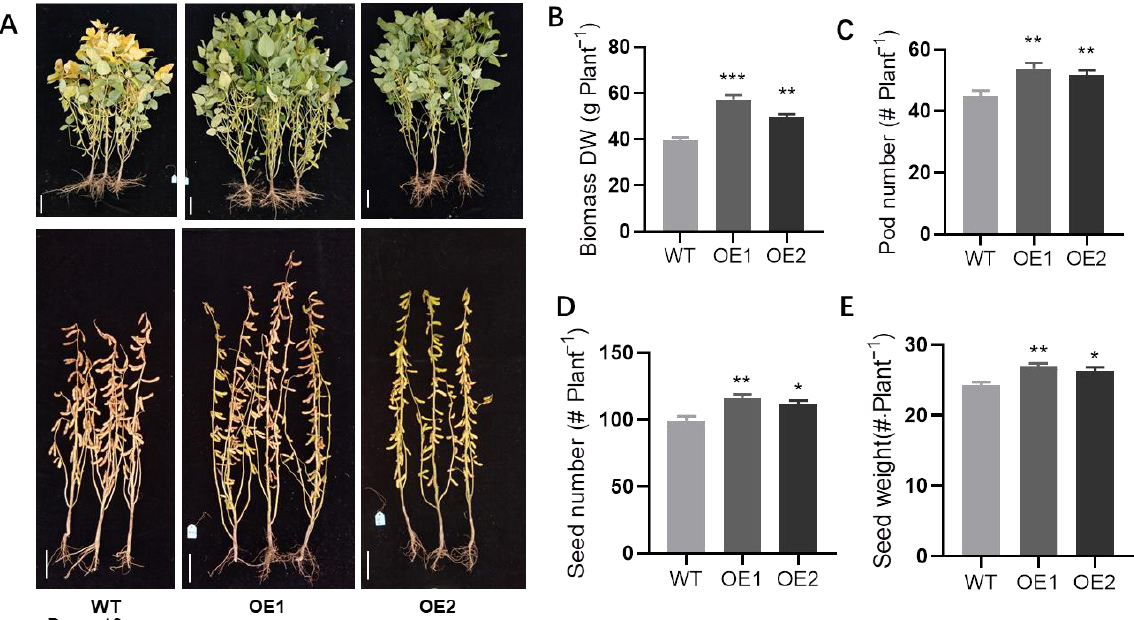
Figure 4. GmPHR1 overexpression promotes growth and increased yield under field conditions. ( A ). Growth performance of wild type and GmPHR1-OE transgenic soybean plants grown under field conditions at the R6 and R7 stages. Bars = 10 cm. ( B , C ). The biomass (DW: dry weight) and number of pods per plant for wild type and GmPHR1-OE transgenic soybean plants grown under field conditions. ( D , E ). The seed number and seed weight per plant of soybean in ( A ). For ( B – E ), asterisks represent statistically significantly differences from respective controls in the Student’s t test (*: 0.01 < p ≤ 0.05, **: 0.001 < p ≤ 0.01, ***: p ≤ 0.001).